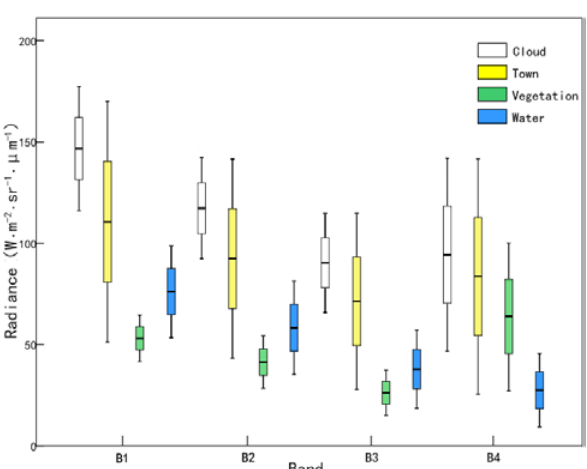
Figure 1. Overall framework of the BOTF algorithm.